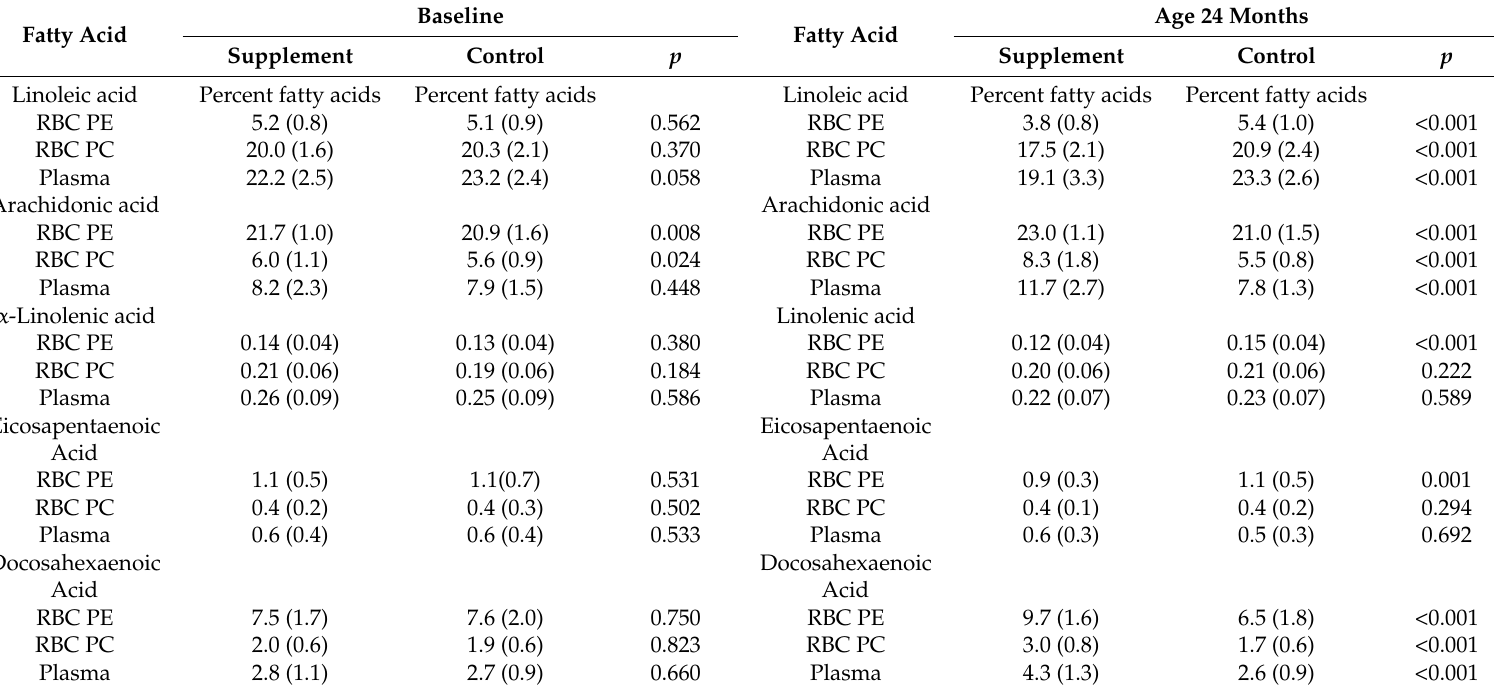
Table 5. Circulating n -3 and n -6 fatty acids levels of children at baseline and age 24